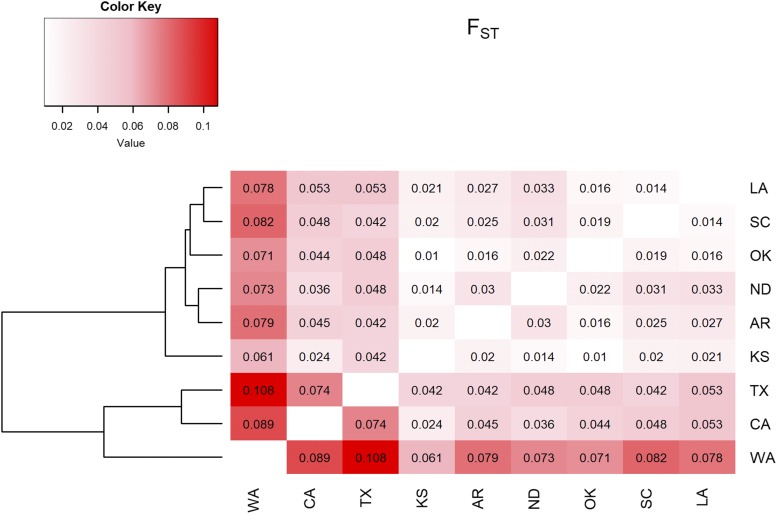
FST population dendogram and heatmap based on FST values Analysis compared a total of 11 R. dominica sampling locations. Darker color represents greater degree of differentiation. The three Kansas location were grouped together and for that reason considered a single location here.